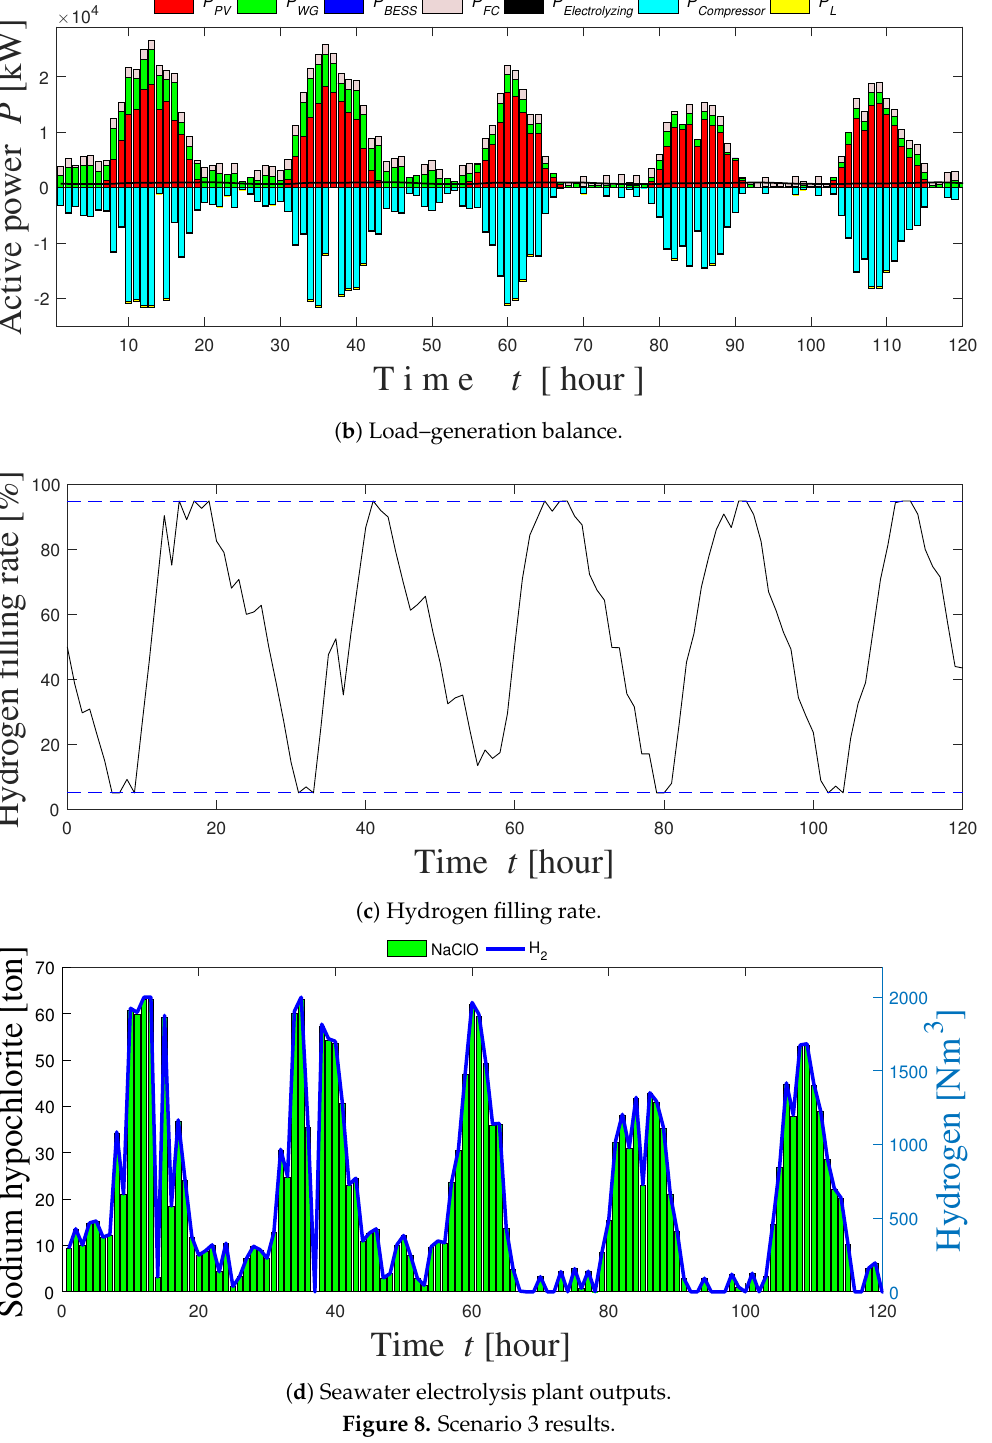
Figure 8. Scenario 3